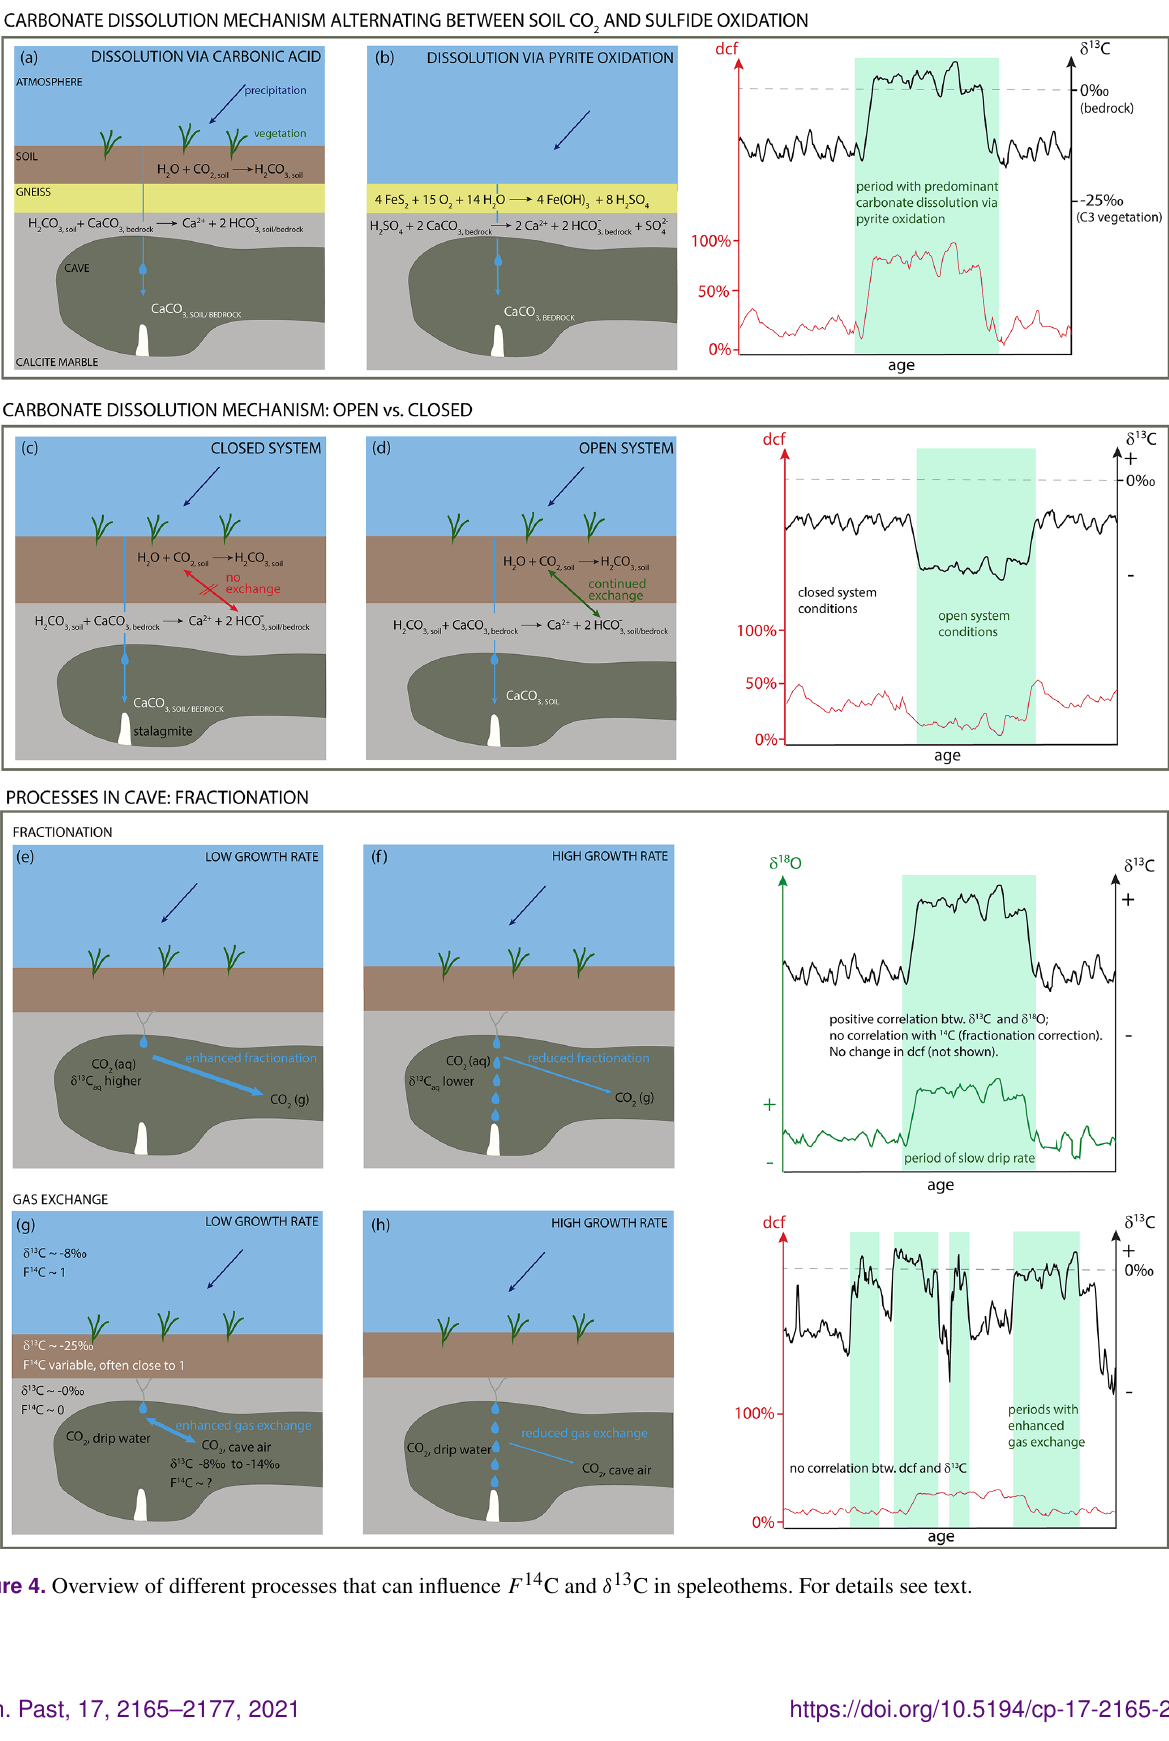
Clim. Past, 17, 2165–2177,